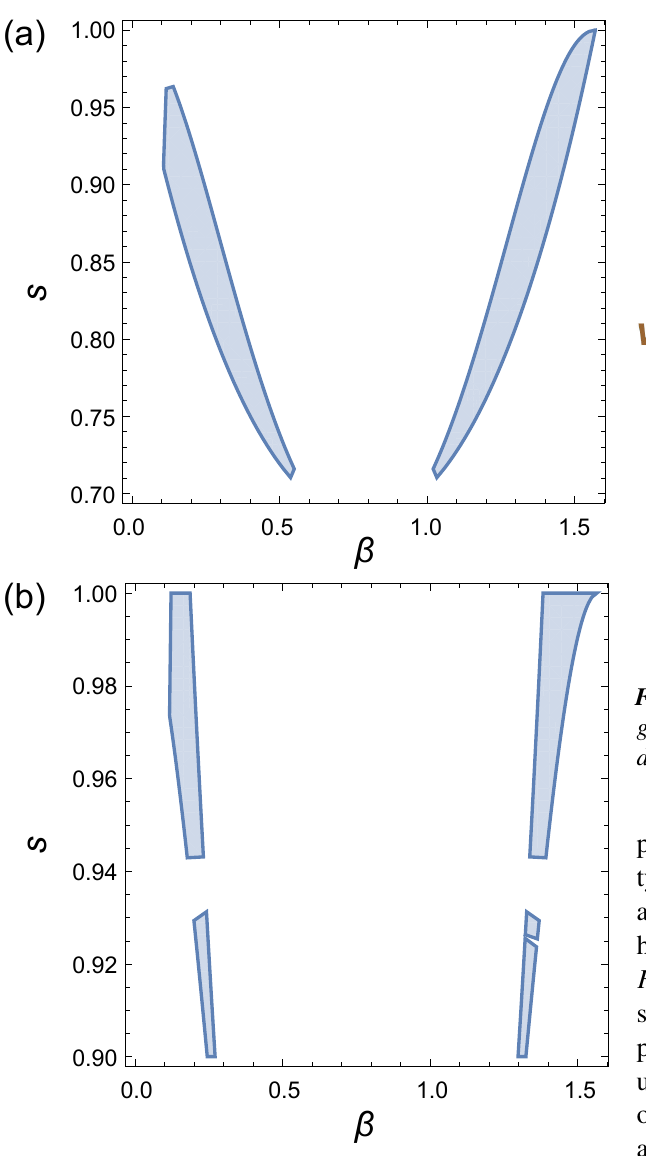
Figure 10: Subfigure (a) gives F 3 unsteerable states (41) useful in the modified QKD protocol. Similarly, the shaded region in subfigure (b) gives steerable states that are useful in the modified protocol. None of these states (in both subfigures) is useful in the QKD protocol (without filtering operations).